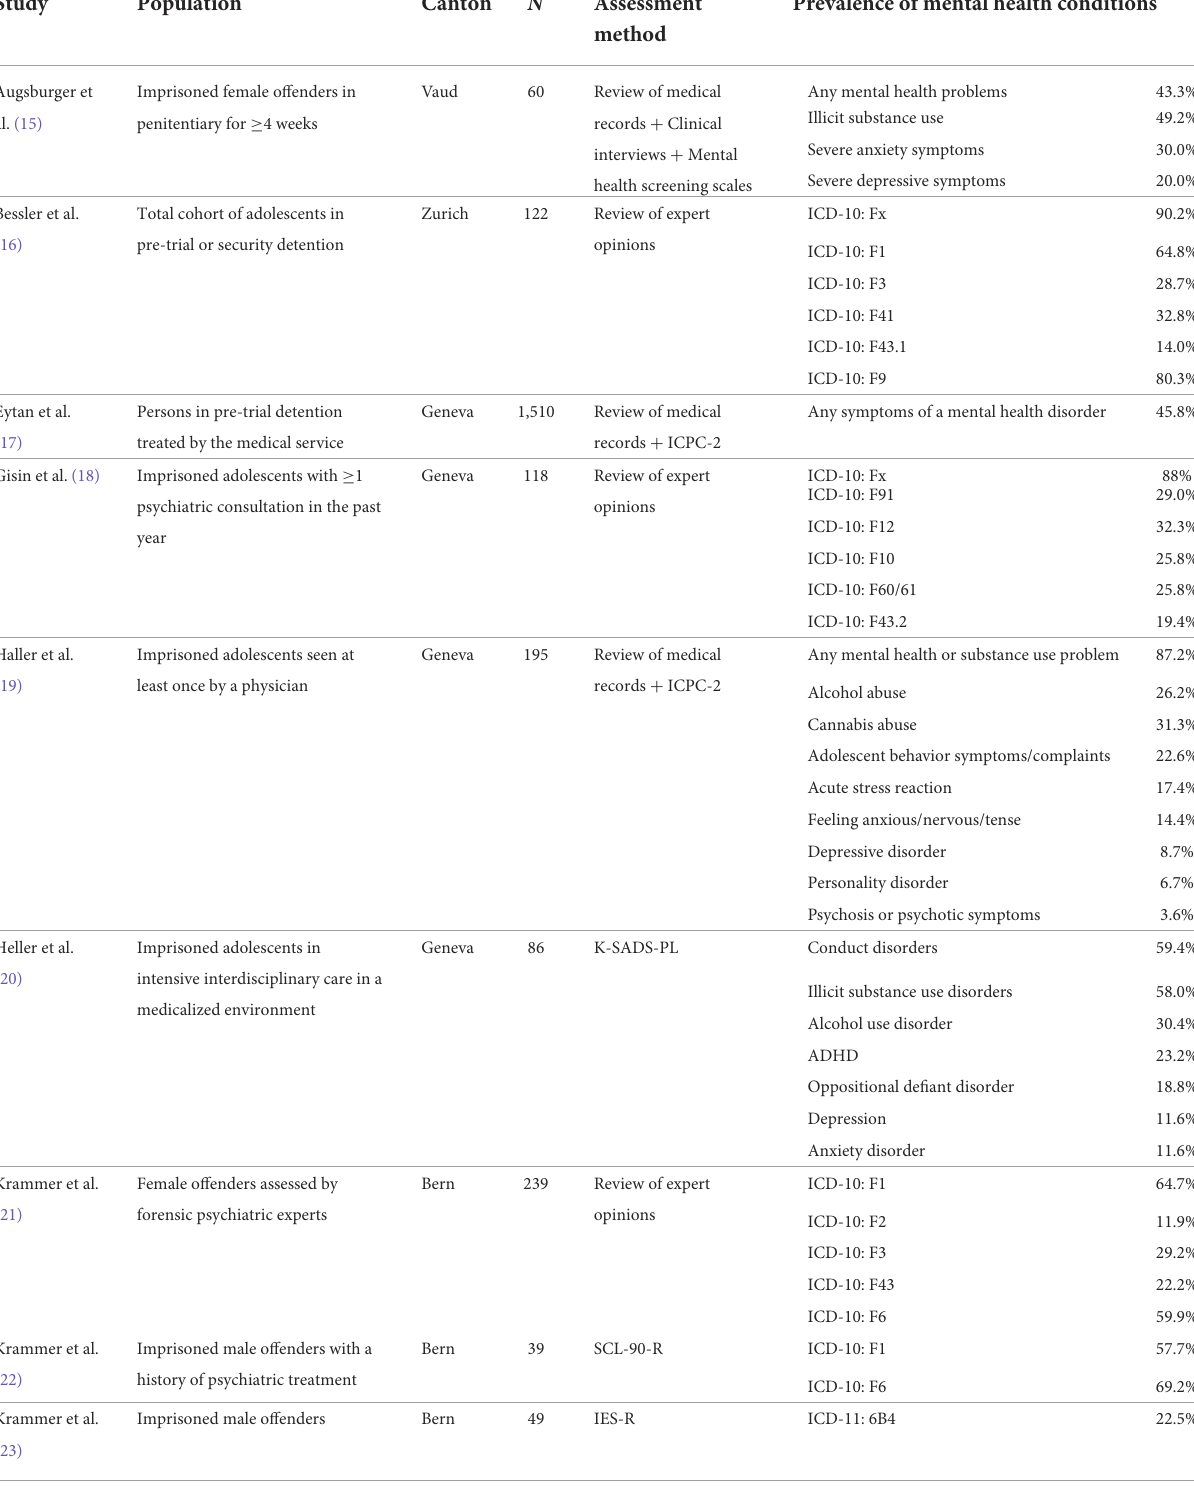
TABLE 1 Peer-reviewed studies on the prevalence of mental health disorders among imprisoned persons in Switzerland. Study